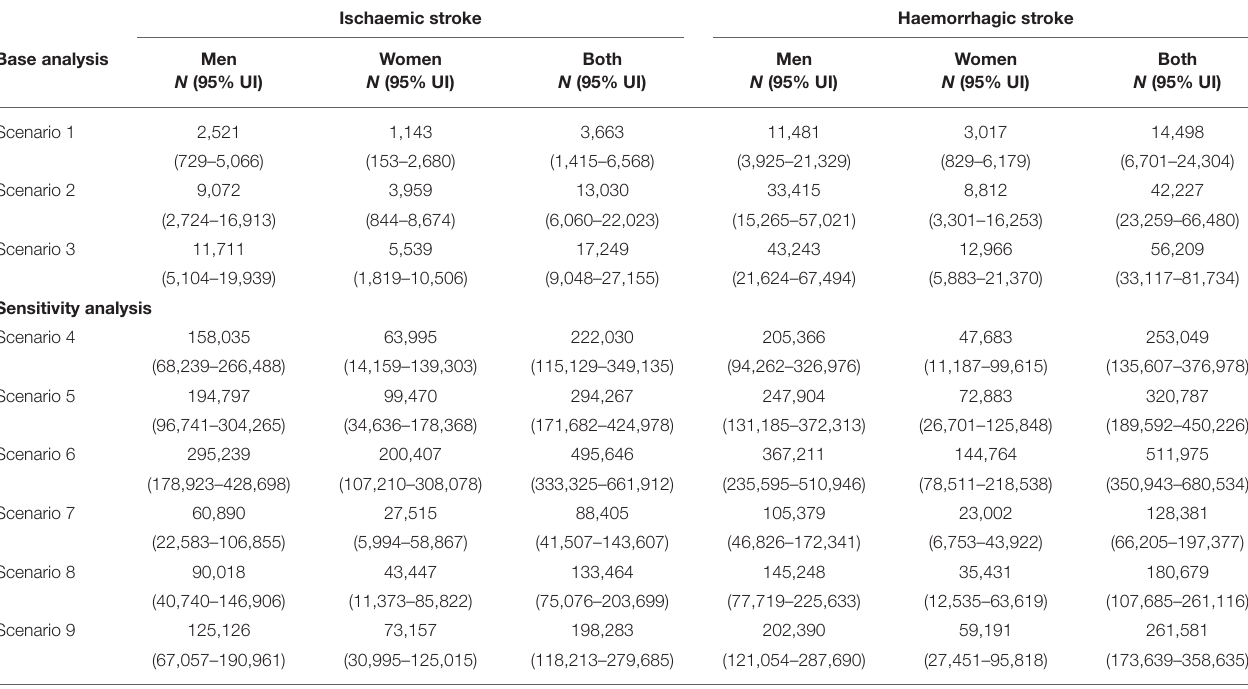
TABLE 3 | Absolute reductions in stroke mortality among adults in Vietnam from 2019 to 2030 and over the lifetime. Ischaemic stroke Haemorrhagic stroke